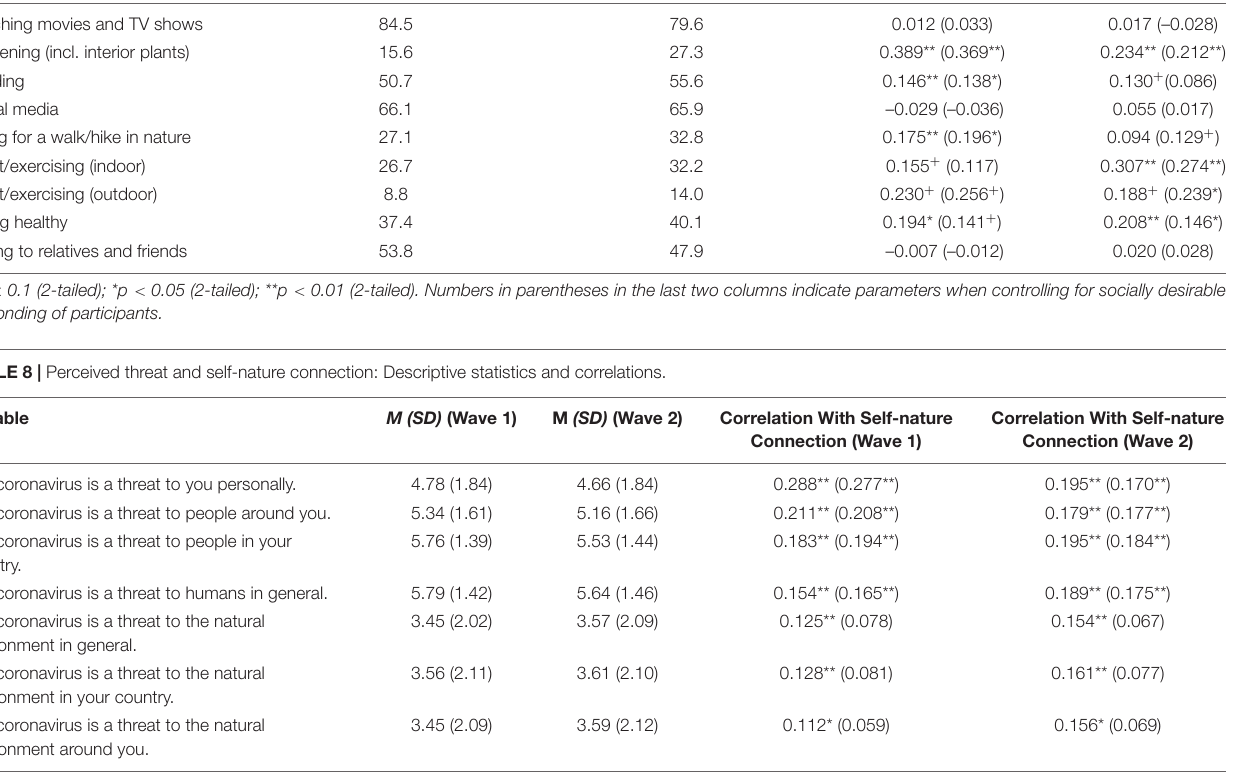
TABLE 7 | Activities people engage in while home and self-nature connection: Frequencies and logistic regression coefficients. Variable